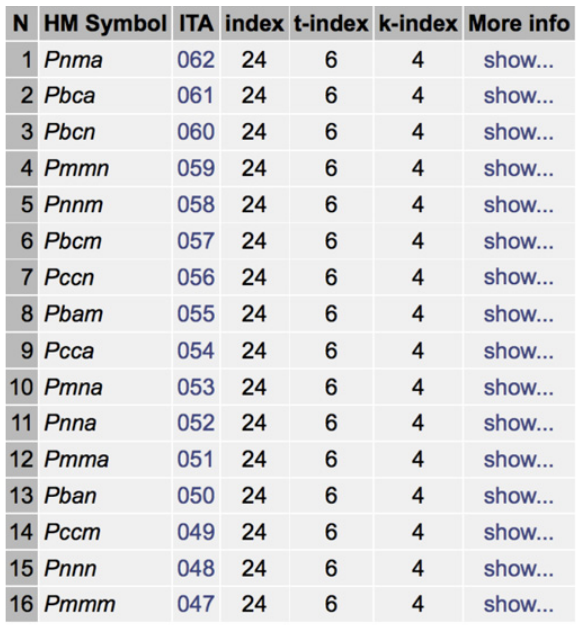
Figure 4. Subgroups (types) of F m ¯3 m with point group mmm , i k = 4 and no centring, as given by CELLSUB .